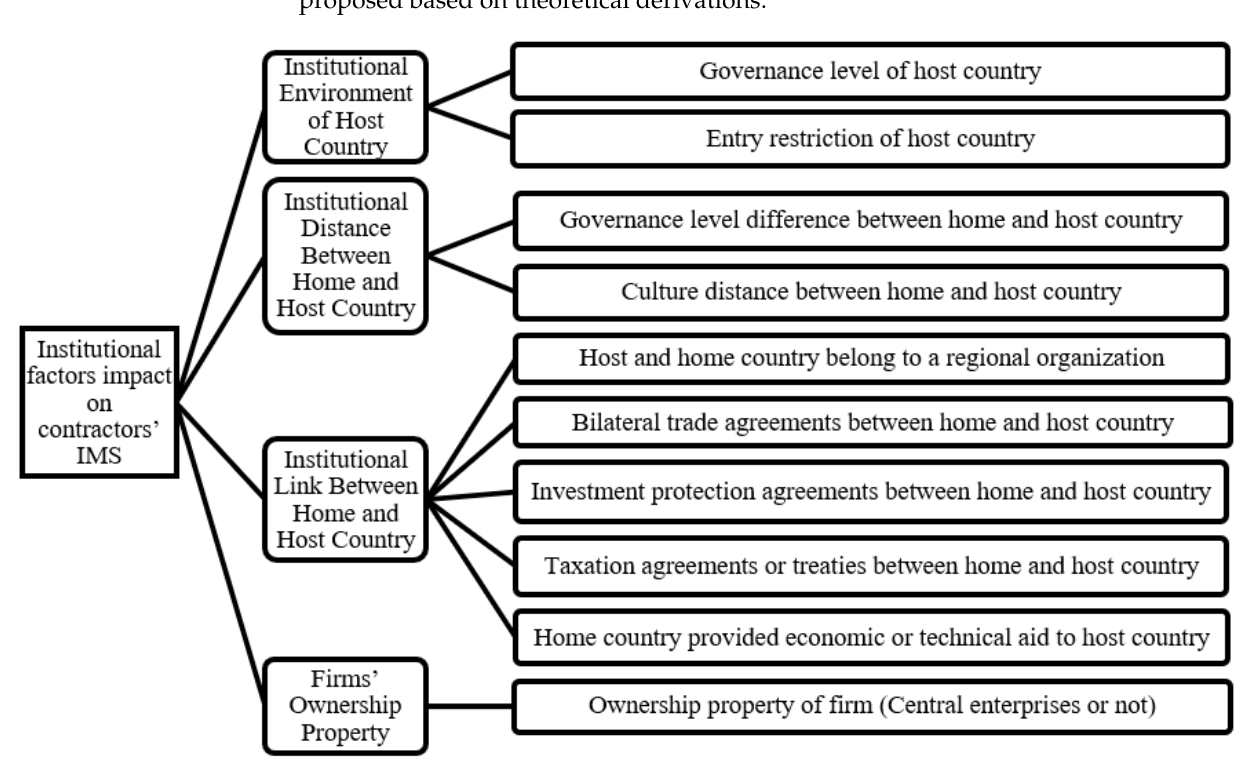
Figure 1. Selected institutional factors from multiple levels for analysis.